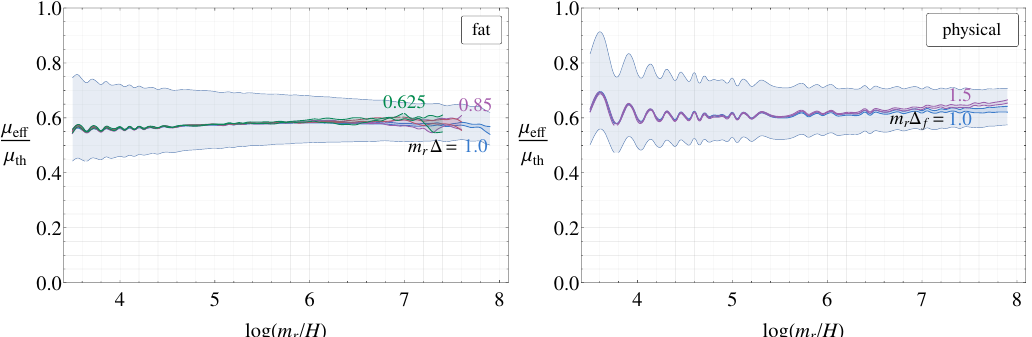
Figure 9: The ratio between the string tension calculated in simulations and the theoretical expectation in eq. (11) for fat (left) and physical strings (right). In both cases results are shown for different lattice spacings, and the blue shaded band indi- cates the effect of varying the parameter η in eq. (11) over the range [ 1